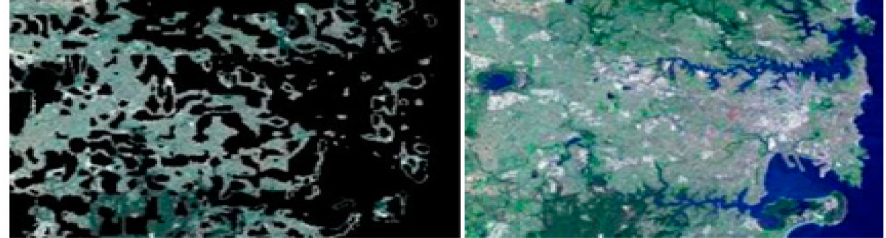
Figure 8. Feature-Based Clustering Segmentation